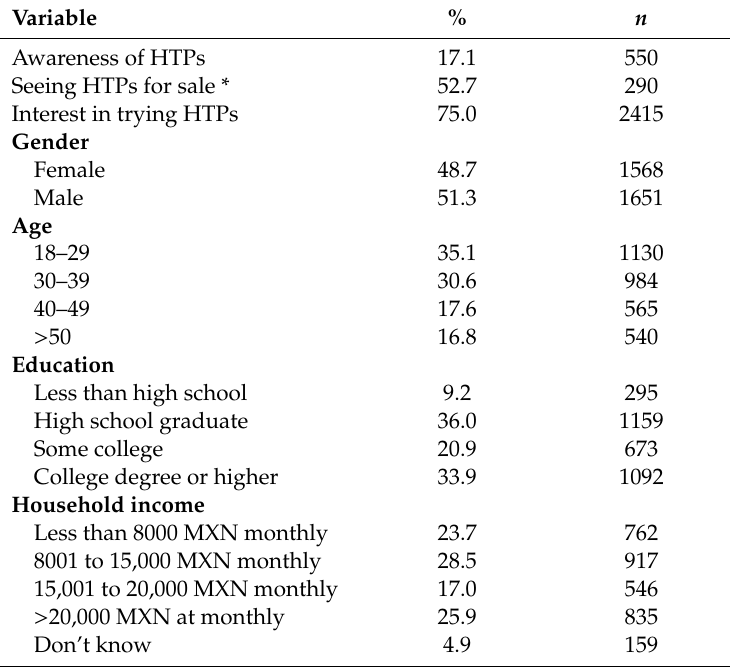
Table 1. Sample characteristics ( n =